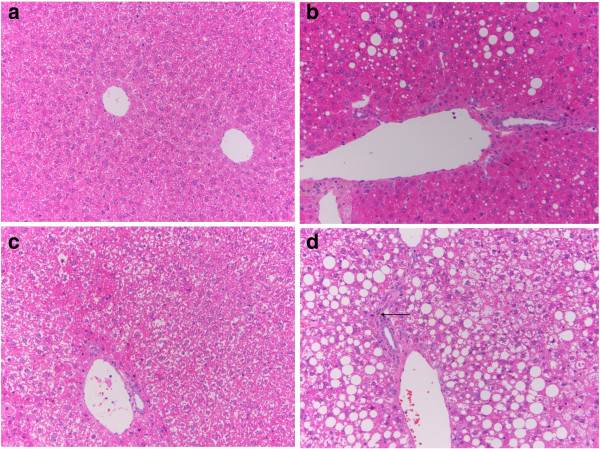
Comparison of Nrf2 with respect to liver histopathology. Fresh sections were stained with H & E to demonstrate lipid accumulation and flammatory cell. a. Wide type mouse liver induced by control diet. b. Wide type mouse liver induced by high fatty diet with mild hepatosteatosis consisting of mixed microvesicular and macrovesicular fat accumulation. c. Nrf2-null mouse liver induced by control diet with mild granular degeneration. d. Nrf2-null mouse liver induced by high fatty diet with severe and large scale hepatosteatosis consisting of macrovesicular fat accumulation, and mild inflammatory cell infiltration. Arrow indicates infiltrated inflamematory cells.